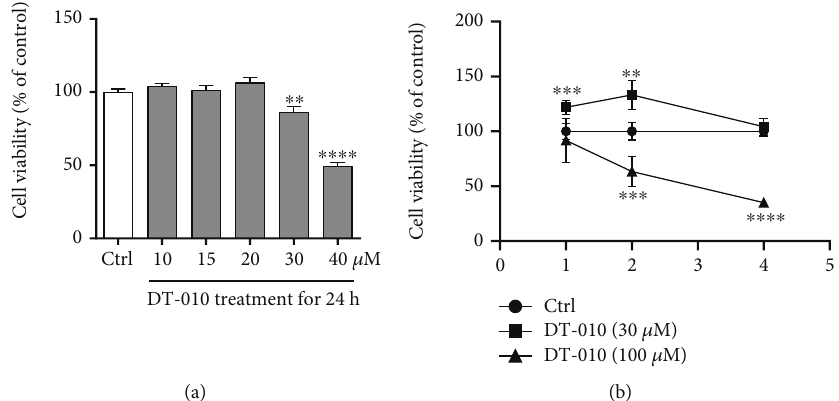
Figure 1: E ff ect of DT-010 on cell viability in H9c2 cells. (a, b) Cell viability (% of Ctrl) was measured by the MTT assay. ∗∗ P < 0 : 01 , ∗∗∗ P < 0 : 001 , and ∗∗∗∗ P < 0 : 0001 versus the Ctrl group. Data are mean ± SD of three independent experiments. Data were analyzed using one-way ANOVA or two-way ANOVA and Dunnett ’ s multiple comparison